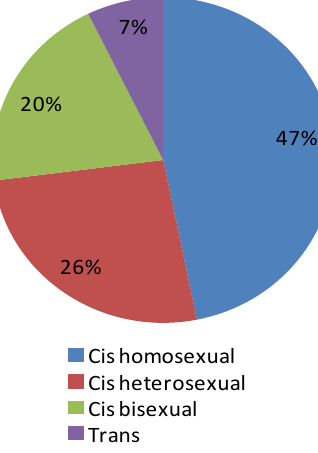
Fig. 1 – Proportion of each group taken into account